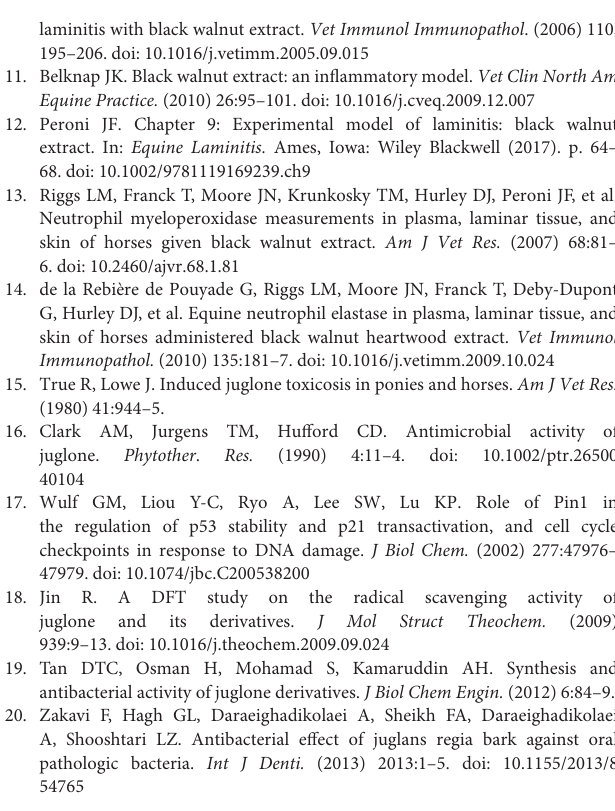
Supplementary Figure 1 | Effect of hydrogen peroxide (H 2 O 2 ) on the reactivity of increasing concentrations (from 0.1 µ M to 50 µ M) of juglone in the complete reaction mixture (nitrite and Amplex Red) but without MPO (H 2 O 2 , no MPO). Positive Ctrl MPO and DMSO: complete